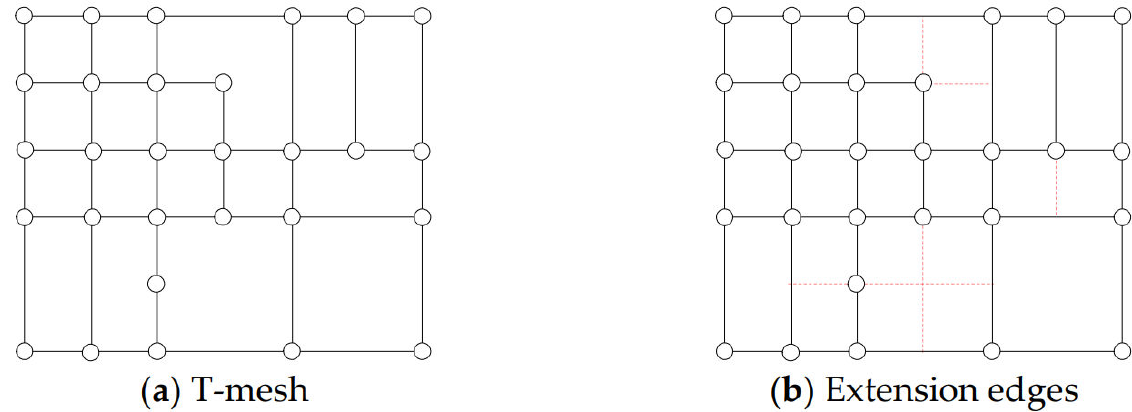
(cid:17) (cid:16) u i 0 , v j 0 , this 0 0